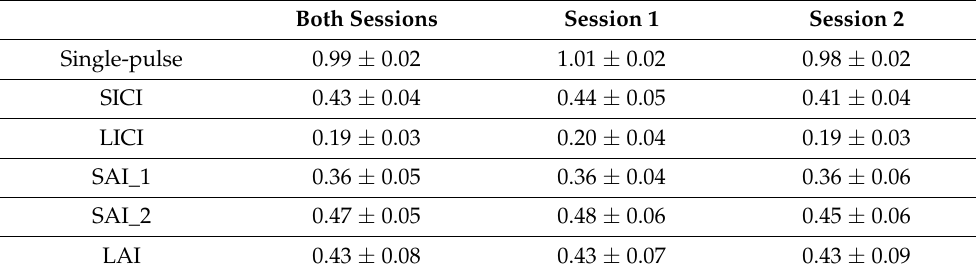
Values are expressed as mean ± SEM. Abbreviations: SICI, short-interval intracortical inhibition; LICI, long- interval intracortical inhibition; SAI_1, short-latency afferent inhibition with an ISI of 20 ms; SAI_2, short-latency